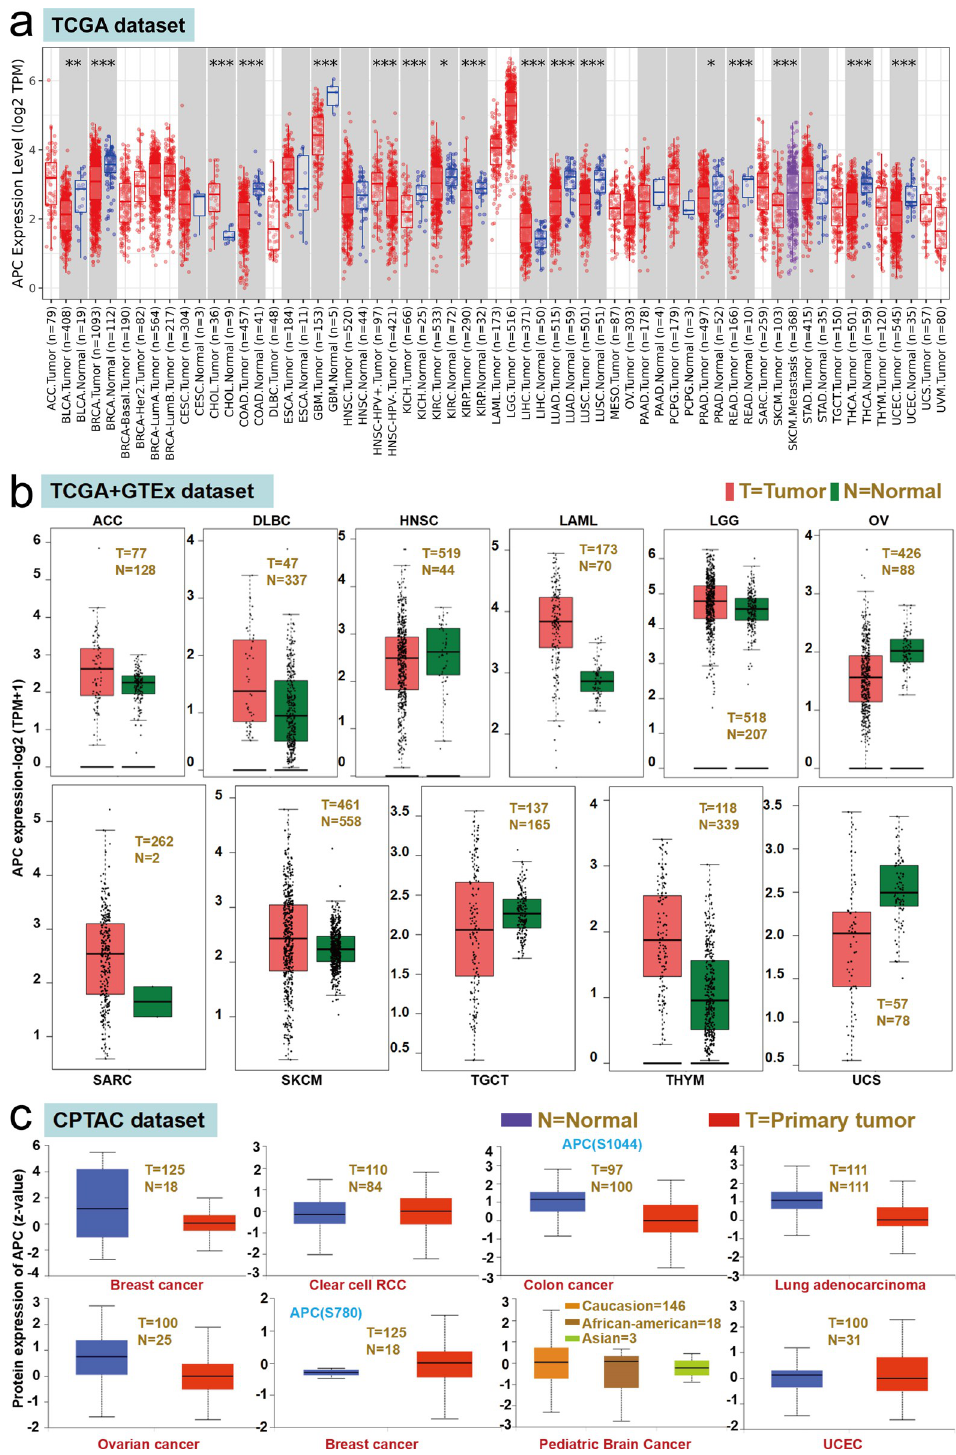
Fig 3. Expression level of APC gene in tumors. (a) The expression status of the APC gene in various cancers via TIMER2. � P < 0 . 05; �� P < 0 . 01; ��� P < 0 . 001 . (b) Based on the TCGA and GTEx datasets, the expression status of the APC gene in adrenocortical carcinoma (ACC), diffuse large B-cell lymphoma (DLBC), head and neck squamous cell carcinoma (HNSC), acute myeloid leukemia (LAML), lower grade glioma (LGG), ovarian serious cystadenocarcinoma (OV), sarcoma (SARC), skin cutaneous melanoma (SKCM), testicular germ cell tumor (TGCT), thymoma (THYM)